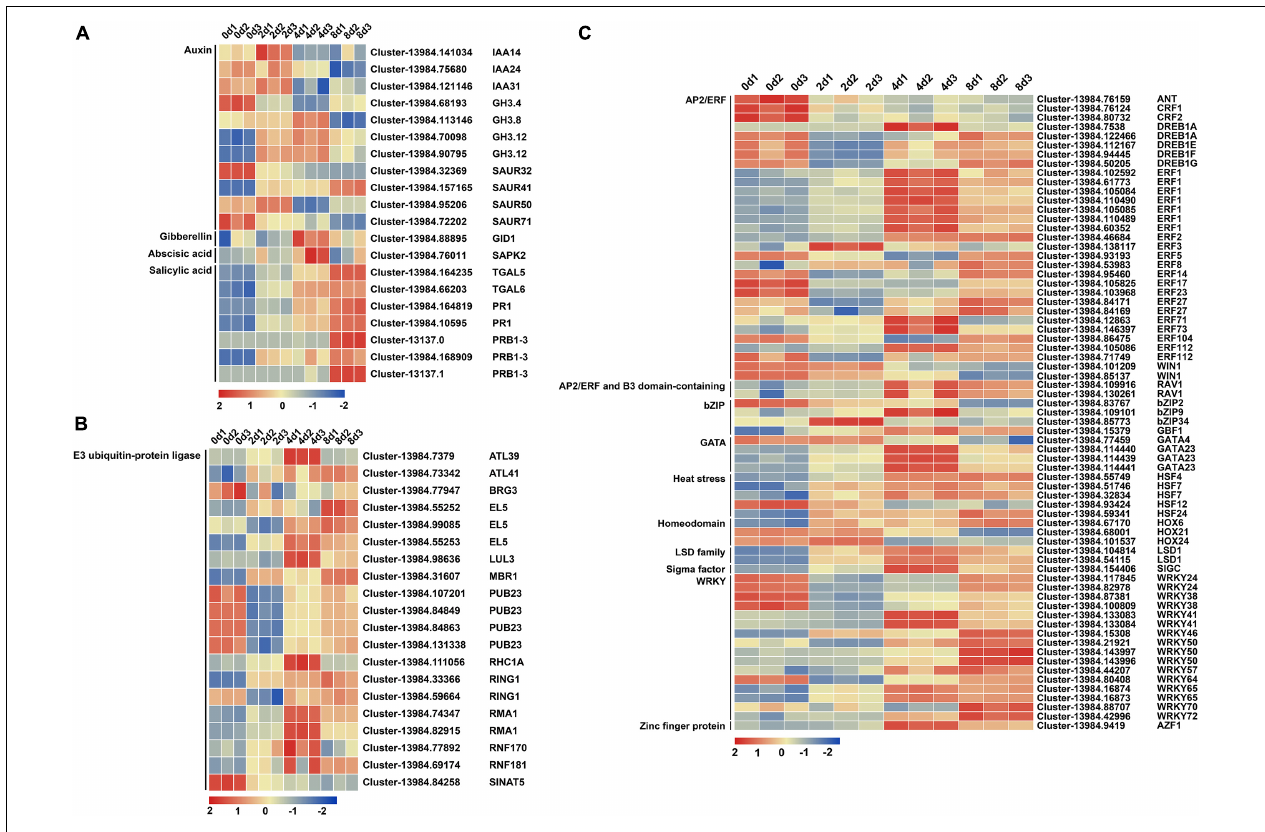
FIGURE 4 | Heatmap of 109 DEGs at four time points after water culture. The 109 DEGs were grouped into (A) “plant hormone signal transduction,” (B) “E3 ubiquitin-protein ligase,” and (C) “transcription factor” categories. The red (upregulated) and blue (downregulated) rectangles are shown with the scale of log2FPKM of each